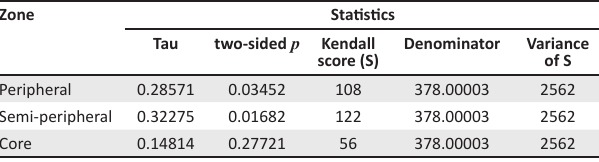
TABLE 4-A1: Test statistics of Mann-Kendall test for trend in the average elephant recruitment rates in areas belonging to different zones.